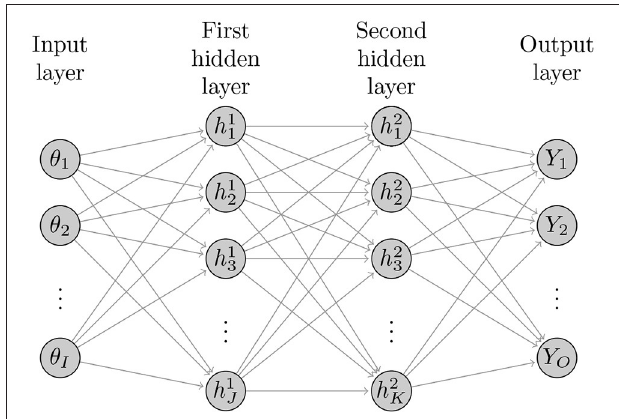
FIGURE 1 | Diagram of general structure of a deep neural network with I inputs, two hidden layers with J and K hidden nodes and O